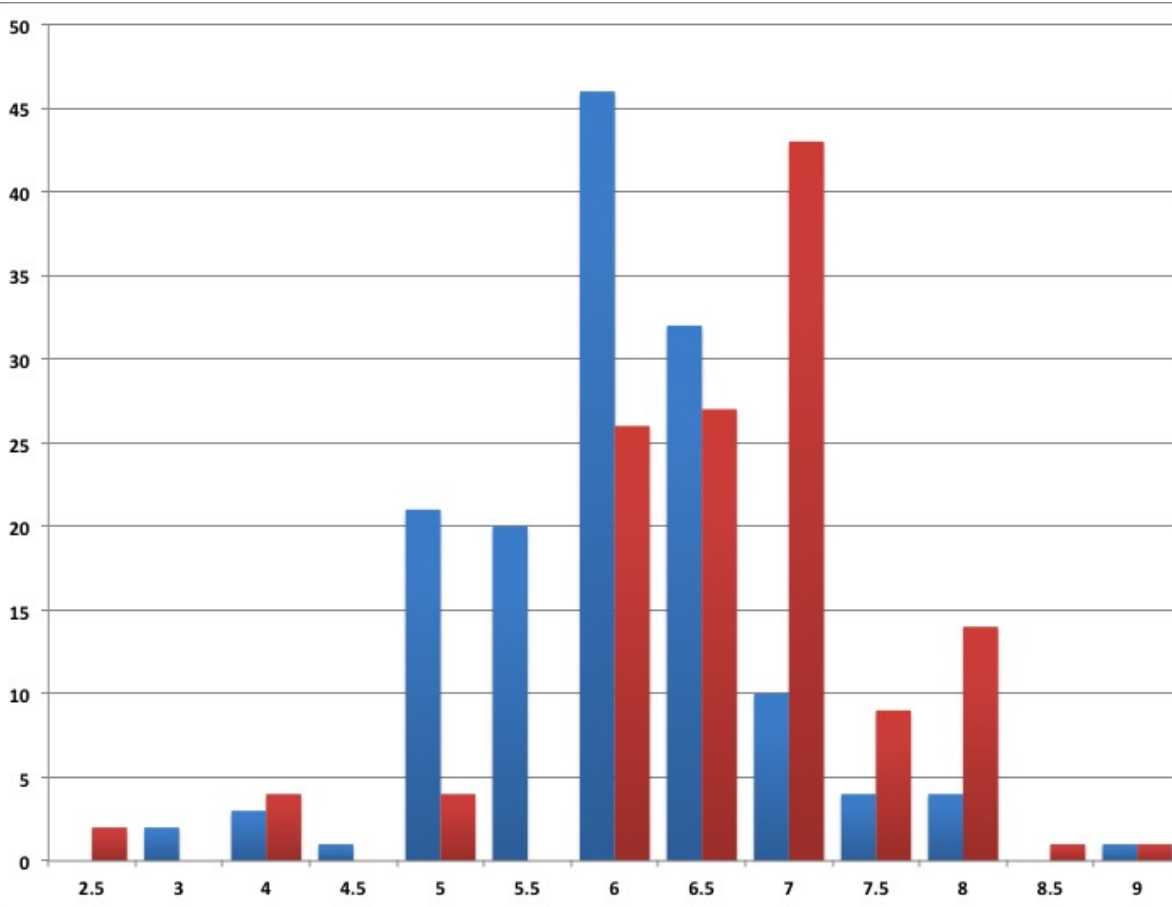
Figure 8. Comparison of the frequency distribution of intensities according to Guidoboni et al. [2007], in red, and to this study, in blue. It is no- tably evident the shifting of about one degree between the two